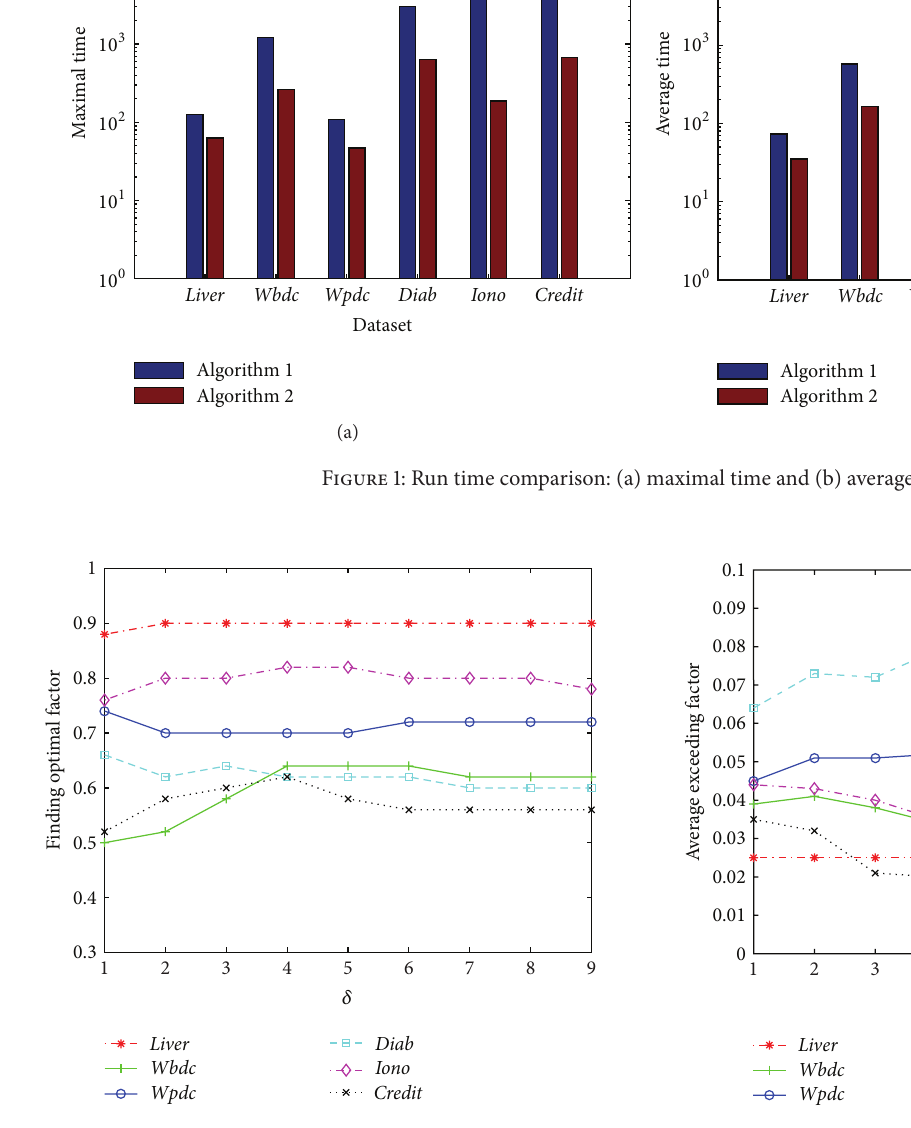
Figure 2: Finding optimal factor. Figure 3: Average exceeding